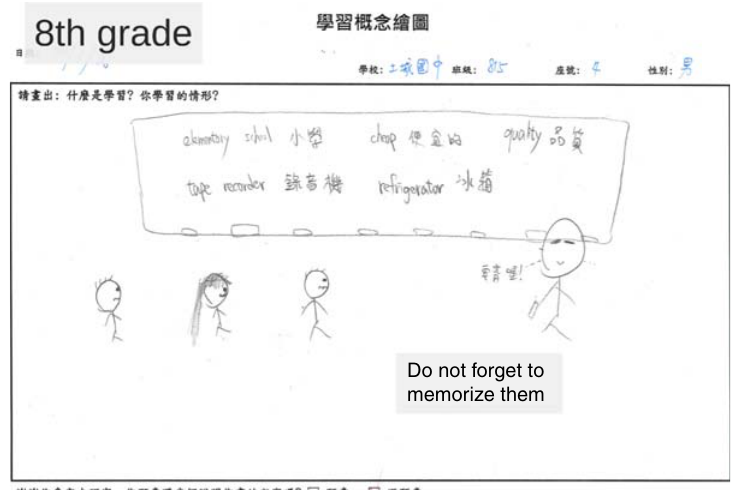
Figure 1. A drawing by a 12th